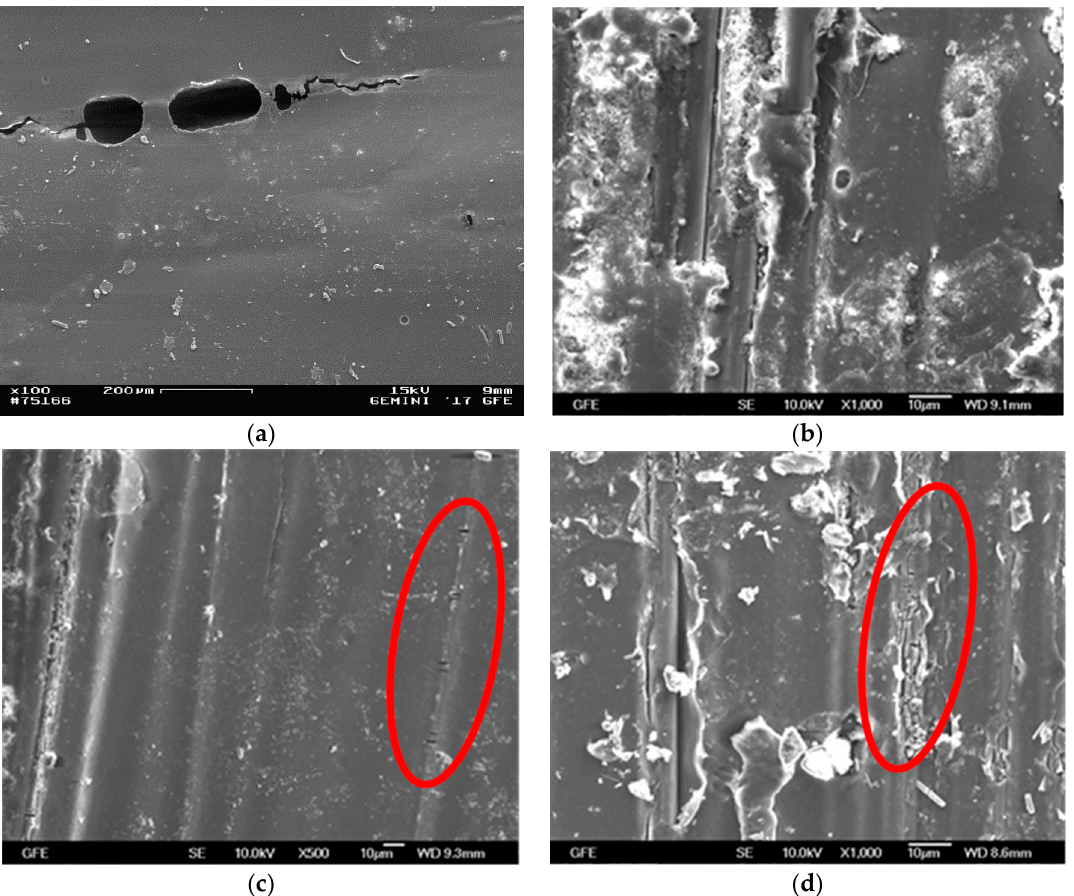
Figure 10. SEM images of S4: unpolarized reference ( a ), after polarization at level 1 ( b ), level 2 ( c ) and level 3 ( d ).